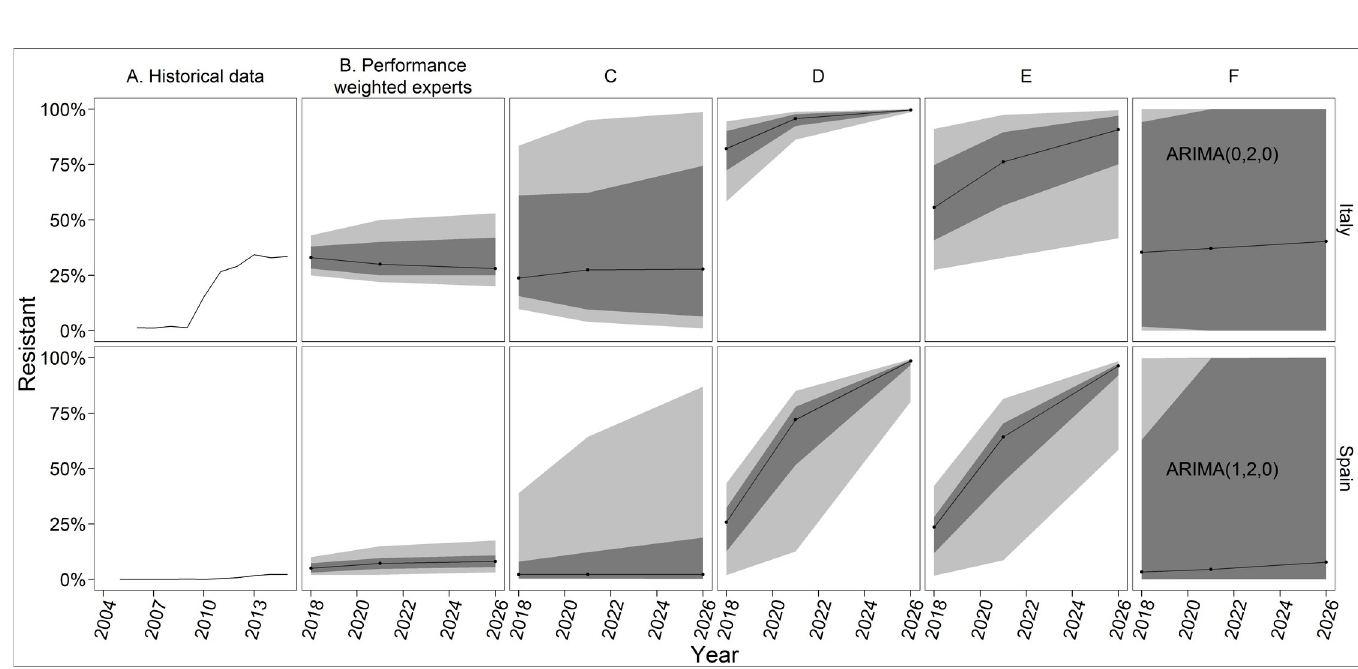
Fig 2. PW and forecasting results for E . coli resistance to carbapenems in Italy and the United Kingdom. All forecasts begin with 2018, 3 years after the most recent historical data. Black lines indicate the median, dark grey indicates the 50% prediction interval, and light grey indicates the 90% predication interval. The experts only assessed 2018, 2021, and 2026. The ETS models use exponential smoothing with additive error, no seasonality, and either no trend (Panel C), an additive trend (Panel D), or a damped trend (Panel E). ARIMA models (Panel F) are labelled with the ARIMA(p,d,q), values selected for that country-pathogen-antibiotic model, where p = the order of the autoregressive model, d = the degree of differencing, and q = the order of the moving average model.